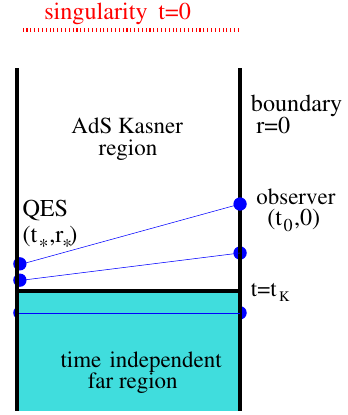
Figure 2 . Cartoon of the 2-dim AdS Kasner geometry (singularity at t = 0 ), the holographic boundary at r = 0 and the QES at ( t ∗ , r ∗ ) , with a time-independent AdS space appended for t > t K . The boundary observer ( t 0 , 0) moves in time from the time-independent region to the AdS Kasner region. The QES lags behind in time, i.e. t ∗ > t 0 , when t 0 is in the Kasner